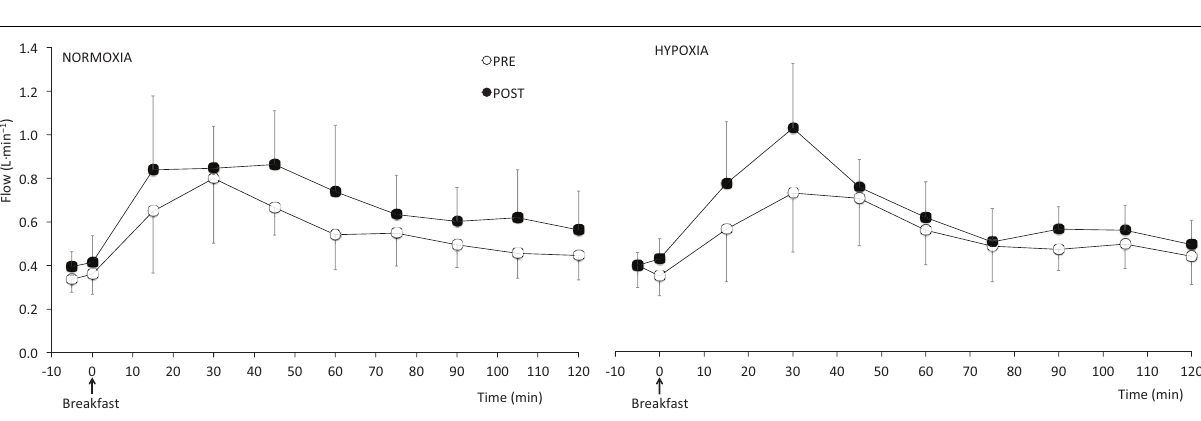
FIGURE 3 | Postprandial delta blood glucose and serum insulin before (PRE), and at the end (POST) of the 10-day normoxic (NORMOXIA) and hypoxic (HYPOXIA) confinements. Values are mean ± SEM, n = 8. ∗ Significant differences between PRE and POST confinement; p < 0.05.